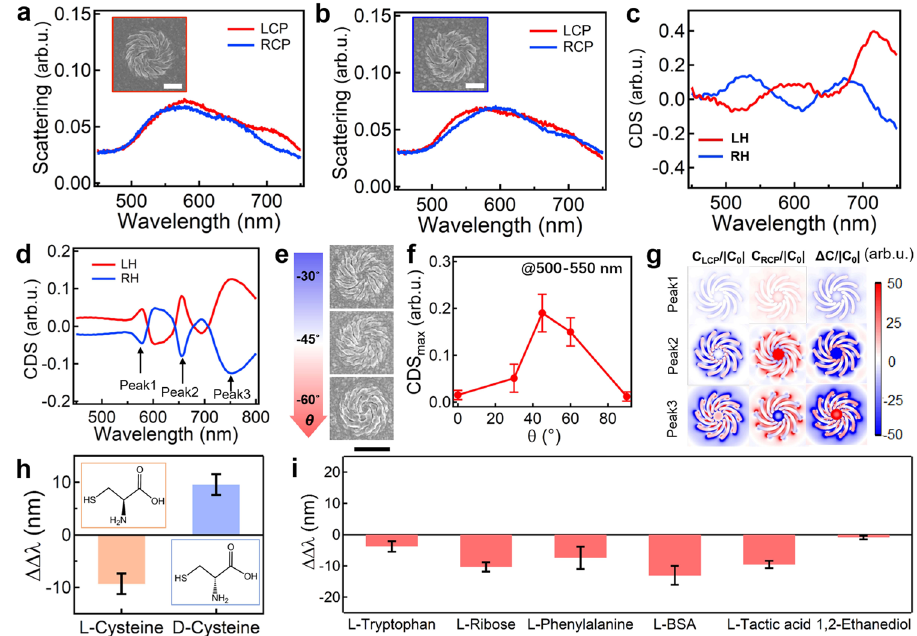
Fig. 4 | Chiroptic property of chiral Au nanostructures and their applications for chiral molecule sensing. Scattering spectra of a LH and b RH chiral nanos- tructures with LCP and RCP incidences, and their corresponding c CDS spectra. Insets are the corresponding SEM image of the LH and RH enantiomers. Scale bars are 500nm. d Simulated CDS spectra of LH and RH chiral nanostructures. e SEM imagesofchiralnanostructureswithincreasing θ .Scalebaris1 μ m. f ChangeofCDS intensity (peaks@500-550 nm) with θ . g Near fi eld optical chirality of different modes marked in ( d ). Sensing application of the chiral plasmonic enantiomers: